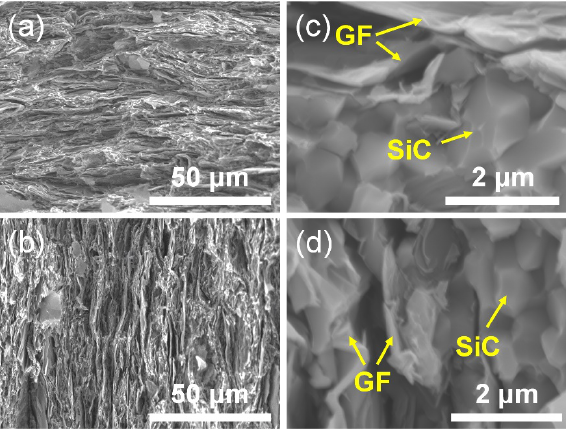
Fig. 7 Fracture surfaces of SiC50/GF composite obtained along (a) z axis and (b) x axis. (c, d) Enlarged images corresponding to (a) and (b),